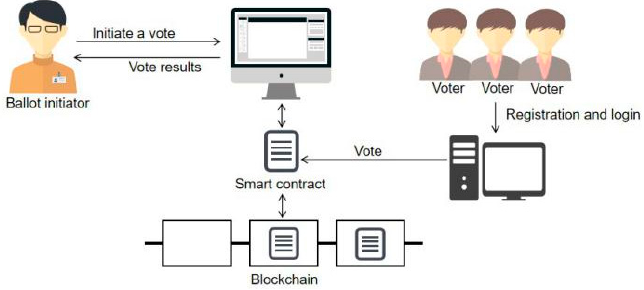
Figure 1. Basic framework of the blockchain voting system.